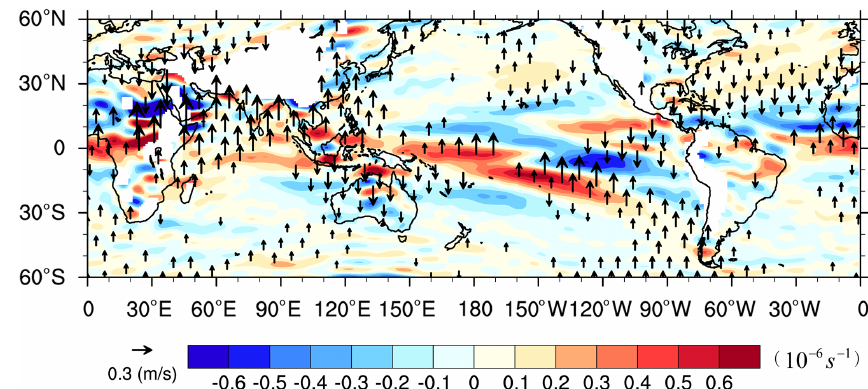
Figure 9. The changes in meridional wind V M decomposed from the 3P-DGAC method at the 850hPa level (vectors; in ms − 1 ), overlaid by its divergent circulations (shading; in 10 − 6 s − 1 ). Only vectors where at least 10 of 13 simulations in the model group agree on the sign of the ensemble mean are shown